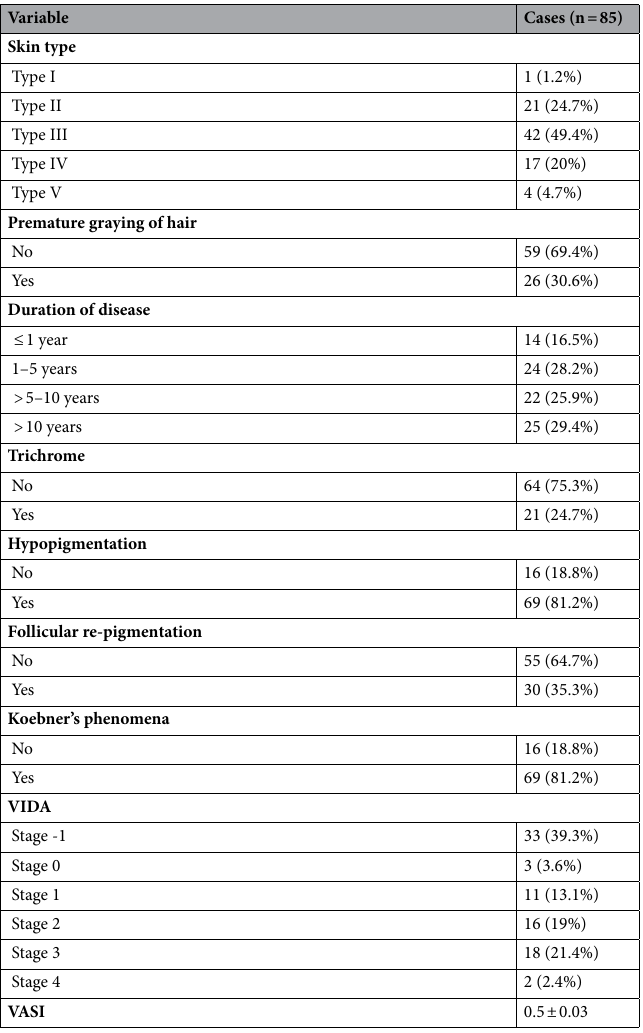
Table 3. Clinicopathological features among vitiligo patients. Data are shown as number (percentage). VASI vitiligo area severity index, VIDA vitiligo disease